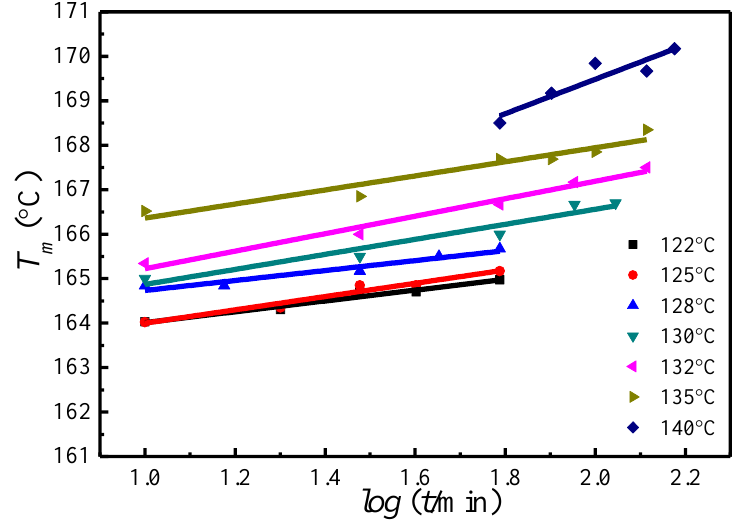
Figure 5. Plots of the observed peak melting temperature versus crystallization time at various crystallization temperatures. Table 1. Parameters Describing the crystallization time dependence of the observed melting temperature and the induction time for the primary stage of isothermal crystallization at different temperatures.